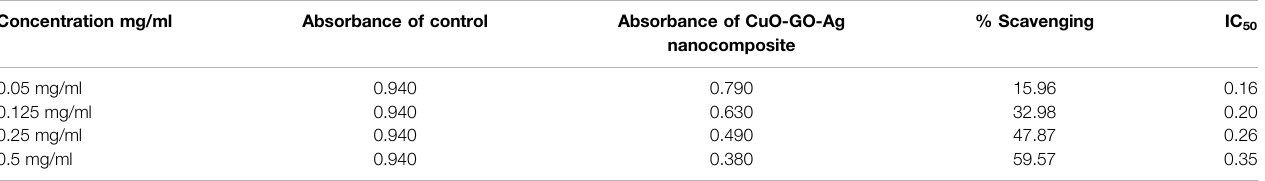
TABLE 4 | CuO-GO-Ag nanocomposite IC50 and percent